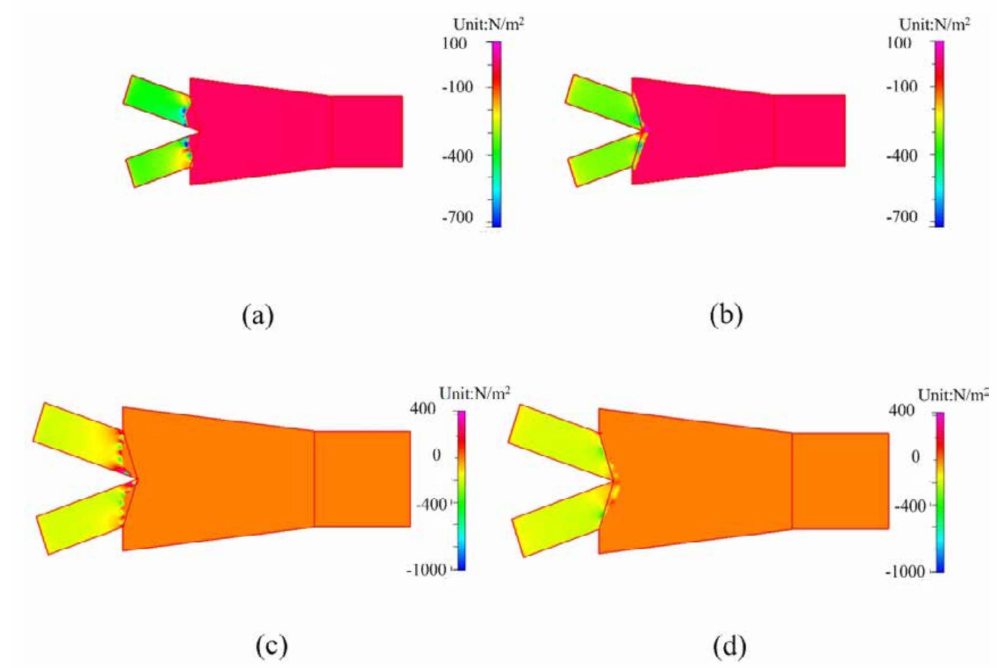
Figure 14. The CFD-ACE simulation results of valve pressure difference of the closed channel ( a , b ) and the open-surface channel ( c , d ) before and after the triggering